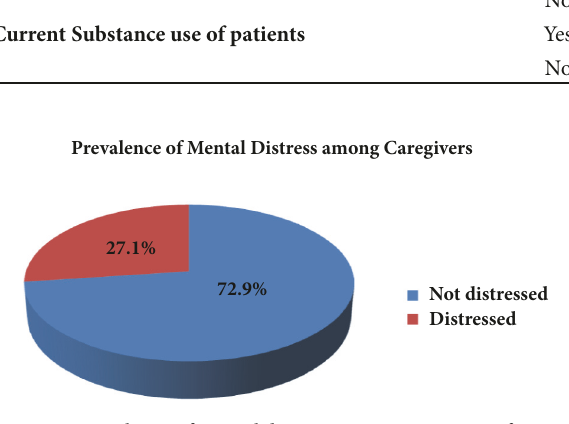
Figure 1: Prevalenceof mental distress among caregivers of patients withepilepsyatAmanuelMentalSpecializedHospital,AddisAbaba, Ethiopia, 2017